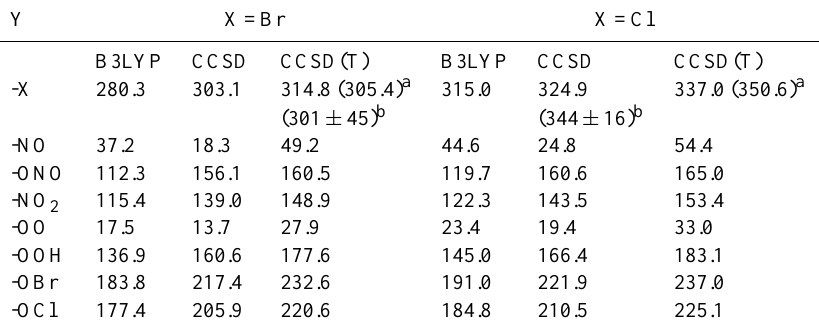
Table 1. XHg-Y bond energies in kJmol − 1 at a temperature of 0K at several levels of theory, including zero-point energy corrections at B3LYP/aVTZ. CCSD and CCSD(T) results are based on single point energies using B3LYP/aVTZ structures. For Y=X, NO, NO 2 , O 2 , HO 2 , BrO, and ClO. Selected results from the previous literature are given in parentheses.